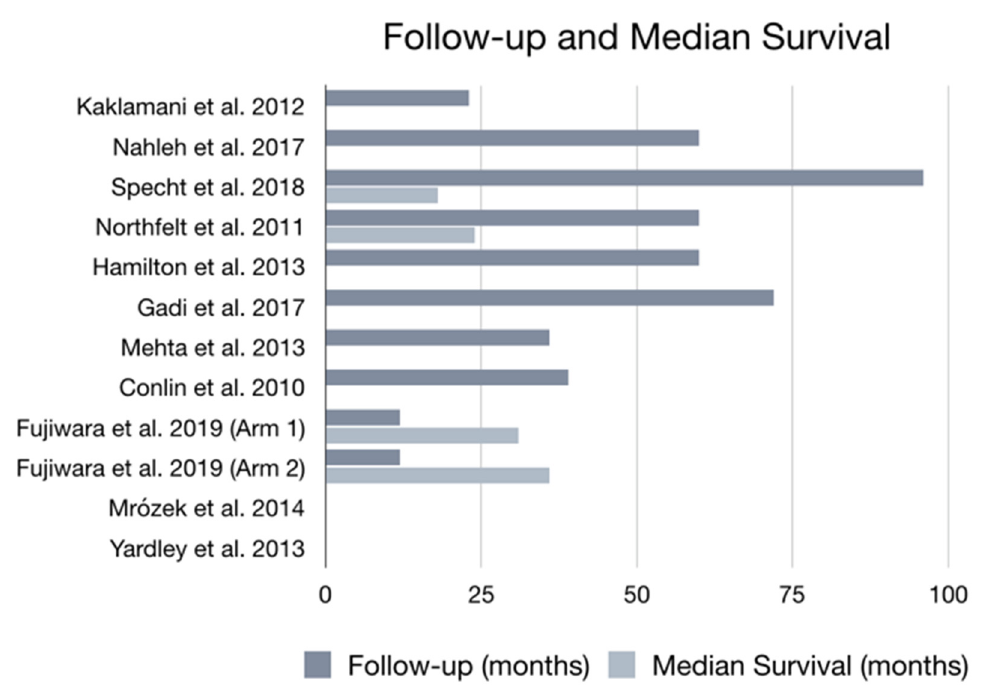
Figure 3. Follow-up and median survival of the reviewed clinical trials, in